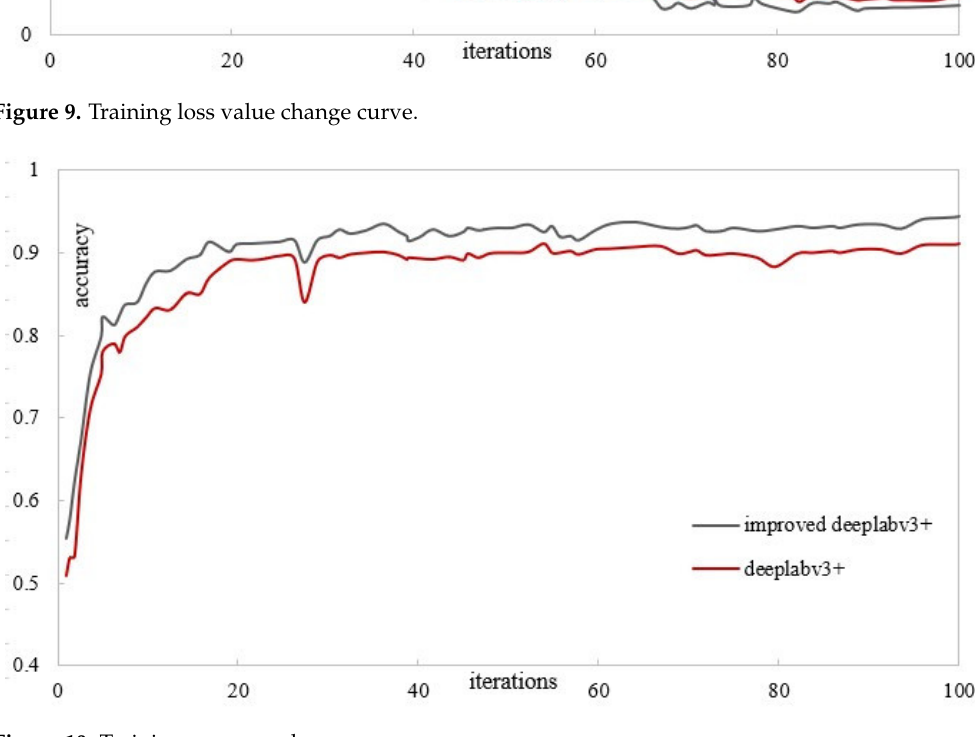
Figure 9. Training loss value change curve.